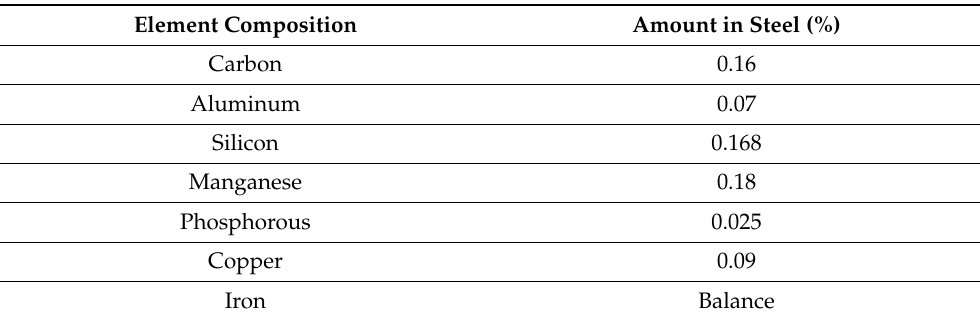
Table 1. The elemental composition of mild steel substrate used for exploring the functionality of the coating.